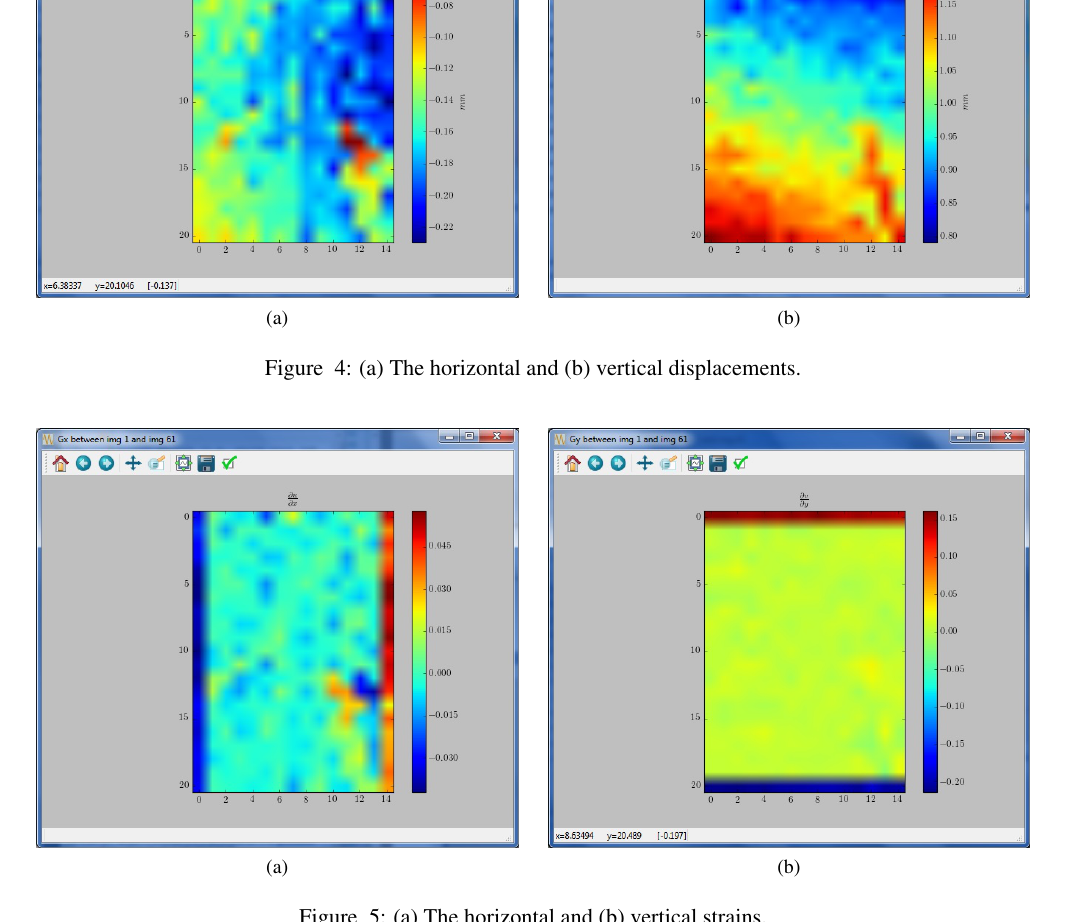
Figure 5: (a) The horizontal and (b) vertical strains.